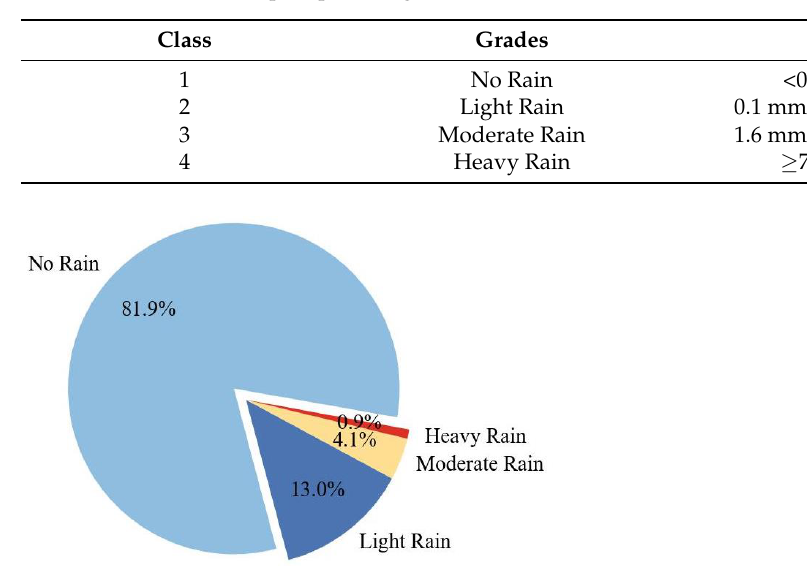
Table 1. Classification of precipitation grades.